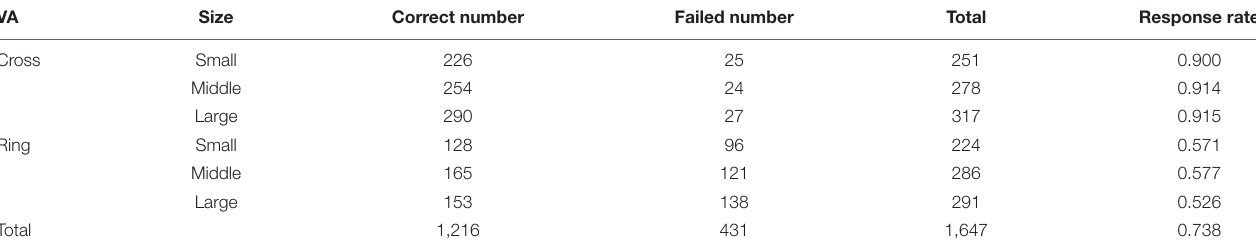
FIGURE 11 | Visualization of response time: (A) cross VA, (B) ring VA. TABLE 2 | Descriptive statistics of response